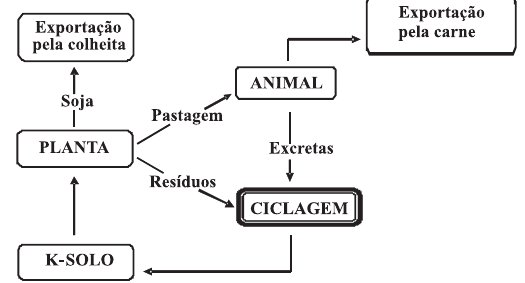
Figura 1. Representação de um ciclo pastagem/soja, com ênfase na ciclagem de K, com seus principais componentes nesse sistema de integração